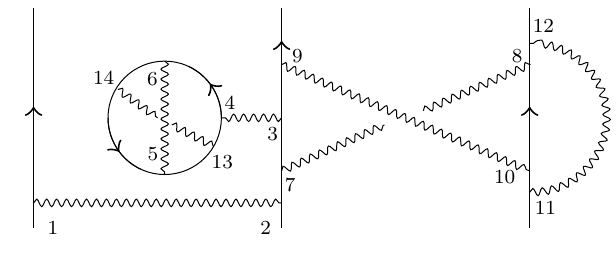
Figure 3 . Feynman diagram corresponding to the permutations (cid:11) = (1 2)(3 4)(5 6)(7 8)(9 10)(11 12)(13 14) , (cid:27) = (^1)(^2 7 3 9)( ^11 10 8 12)(4 6 14 5 13) on the set of half-edges H = f 1 ; 2 ; : : : ; 14 g . The associated ribbon graph is shown in figure 4. A different choice of labelling of half edges and the resulting permutations define an equivalent ribbon graph.